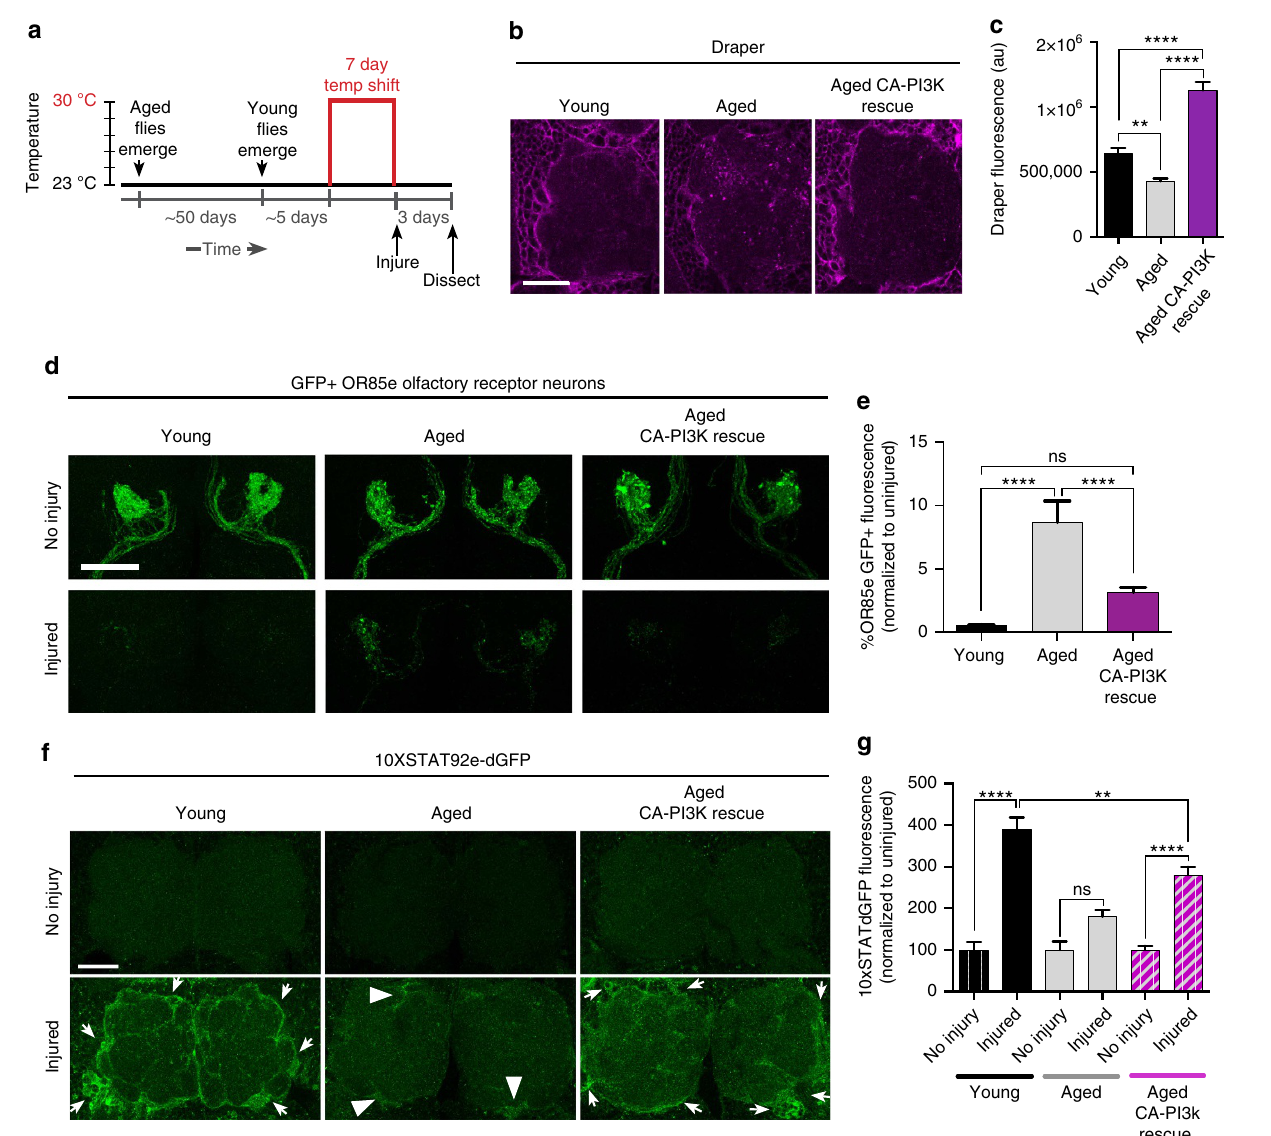
Figure 5 | Expression of CA-PI3K in aged glia rescues glial clearance of axonal debris. ( a ) Schematic of experimental paradigm to induce expression